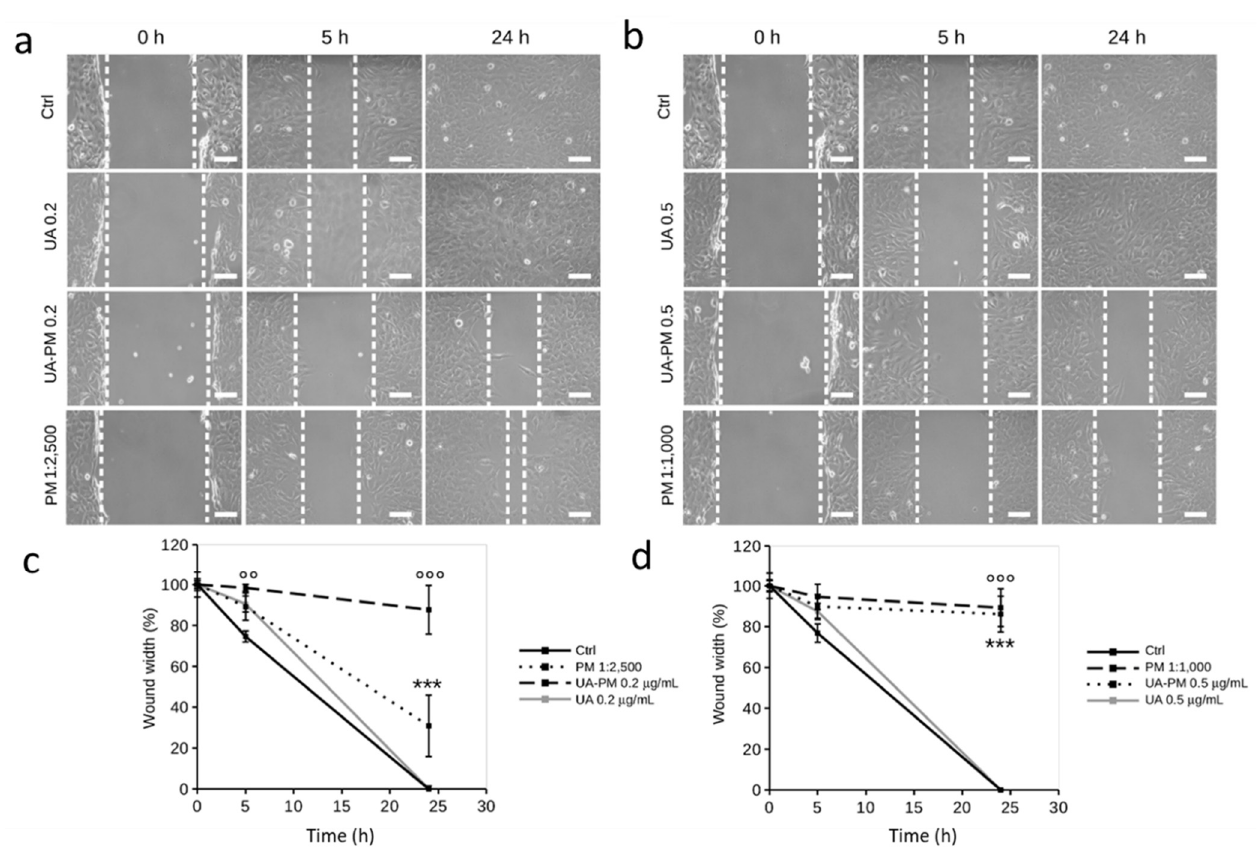
Figure 7. Effect of UA and UA–PM on the migration of SH-SY5Y cells. ( a , b ) Representative image of the migration of SH-SY5Y cells untreated ( − ) or after treatments with UA (0.2 and 0.5 µg/mL), UA–PM (0.2 and 0.5 µg/mL), and PM (1:2500 and 1:1000). Scratch closure was monitored for 24 h. The edges of the wound area are indicated by dashed lines. ( c , d ) Analysis of wound closure over time in SH-SY5Y cells treated under various experimental conditions. ImageJ image analysis software was used to measure and quantify wound width at each time point. Data are representative of three different experiments. Error bars represent standard deviation. *** p < 0.001 vs. untreated control cells; °° p < 0.01, °°° p < 0.001 vs. UA-treated cells.